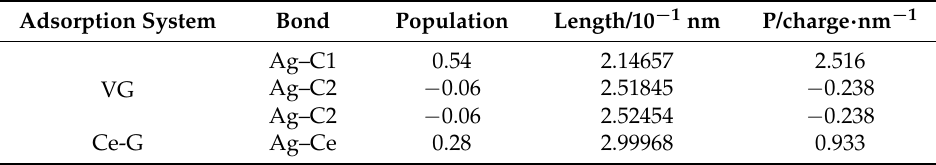
Table 2. The population between the Ag and its nearest C/Ce atom in